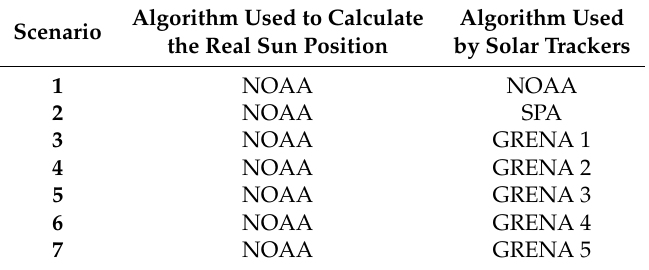
Table 2. Simulation